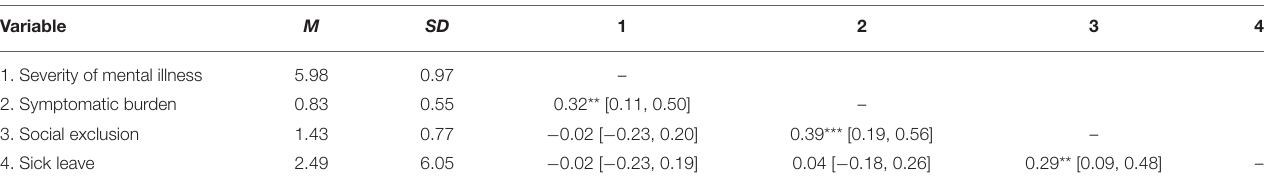
TABLE 2 | Means, standard deviations, and correlations between investigated constructs.